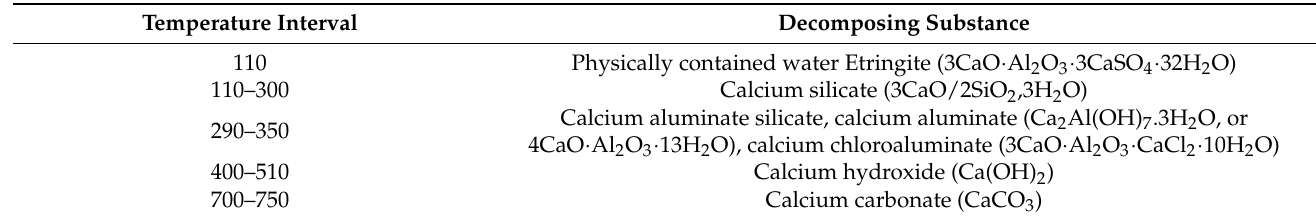
Table 5. Decomposed substances by temperature zone.